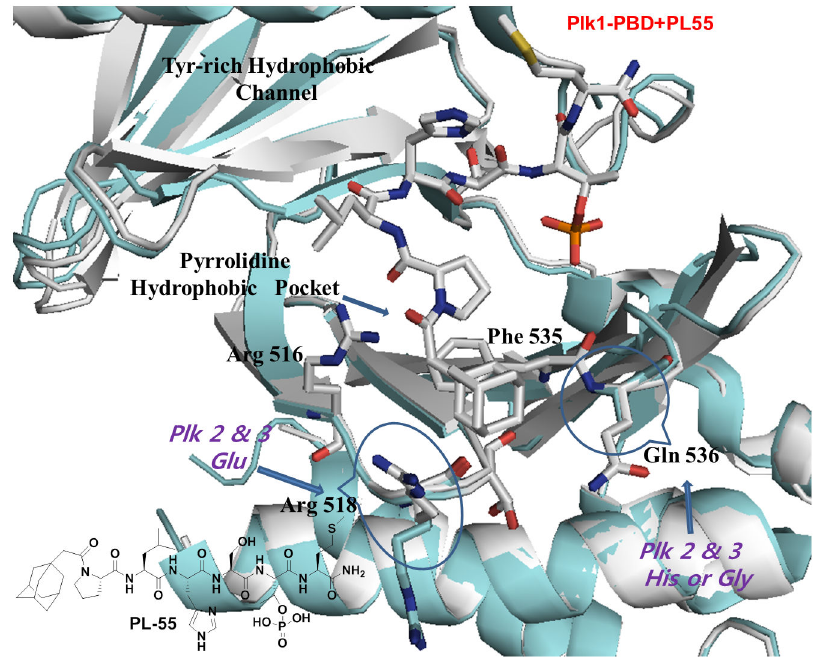
Figure 7. Crystal structures of Plk1 PBD in complex with PL-55. The overlay of the two distinct crystal structures of Plk1 PBD in complex with either PL-55 (gray backbone) or unligated Plk1 PBD (cyan) revealed that the N- terminal adamantyl moiety of PL-55 buried into the broader pyrrolidine hydrophobic region and interacted with unprecedented PBD residues such as Arg 518 and Gln 536.